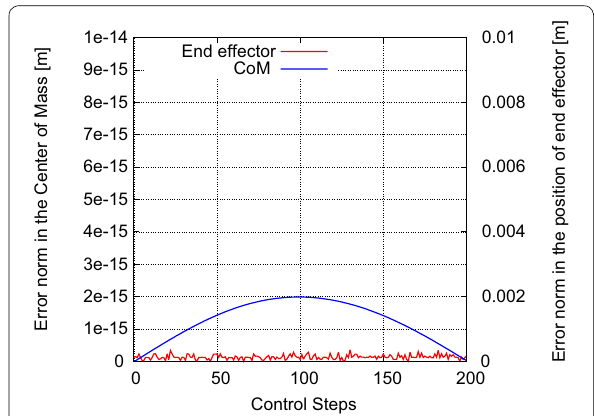
Fig. 12 The error norm of the CoM position and the end effector during the whole-body movement